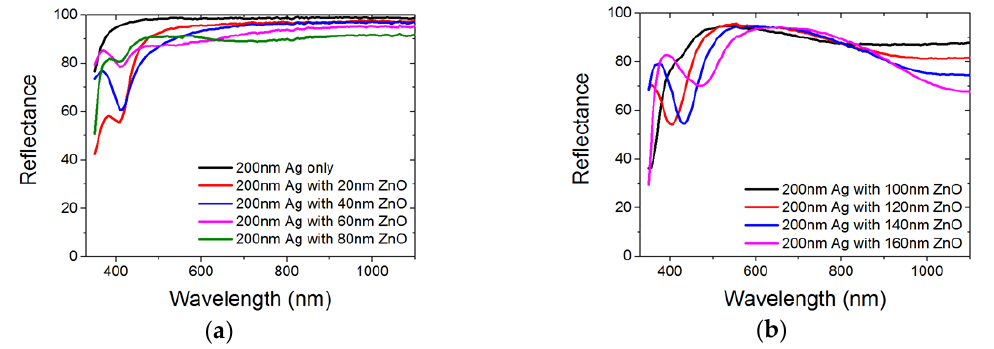
Figure 3. Total reflectance measured on a glass substrate coated with 200 nm Ag and various thicknesses of ZnO (0–160 nm). ( a ) 0–80 nm and ( b ) 100–160 nm.